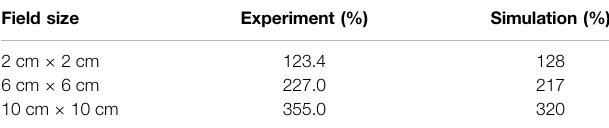
TABLE 1 | Surface dose (70 μ m depth) comparison between the Monte Carlo simulations and the previously conducted experimental measurements using the MO Skin ™ detector. Each of the fi eld sizes is within a ±5% match between the experiment and simulation values. The experimental measurements had an uncertainly in the order of